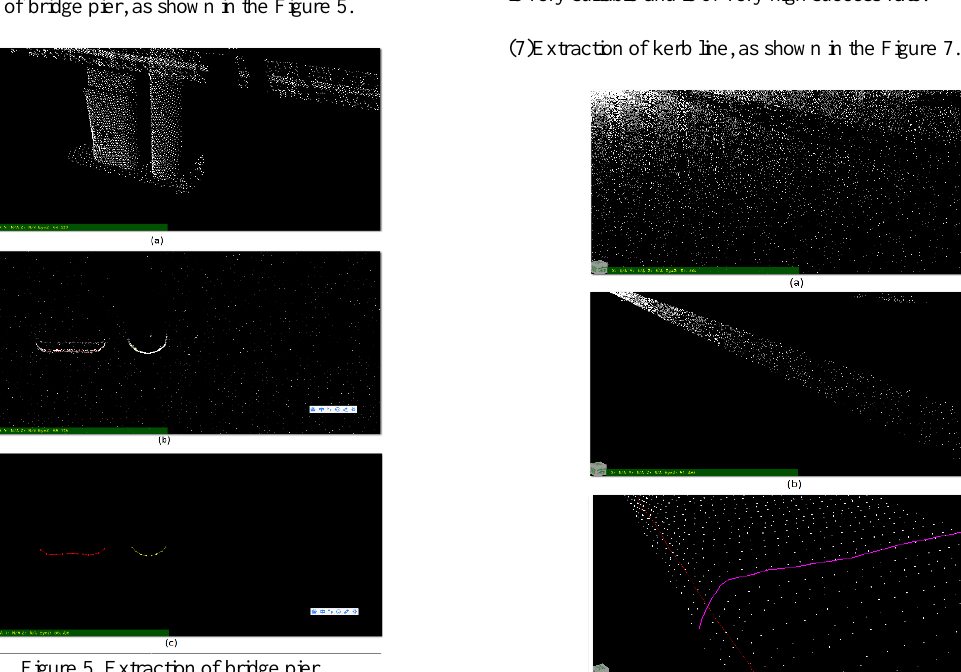
Figure 5. Extraction of bridge pier.